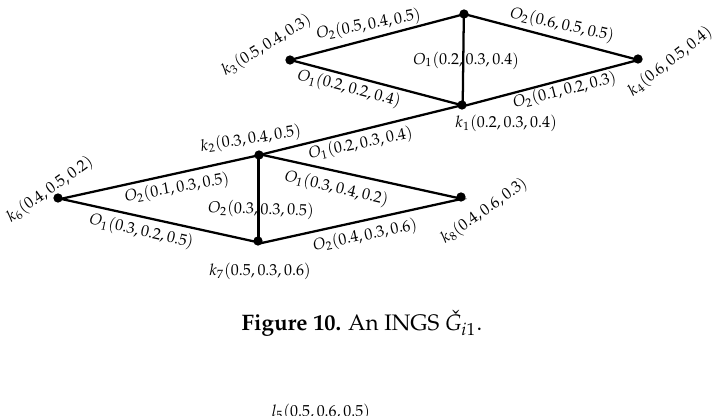
Figure 10. An INGS ˇ G i 1 .